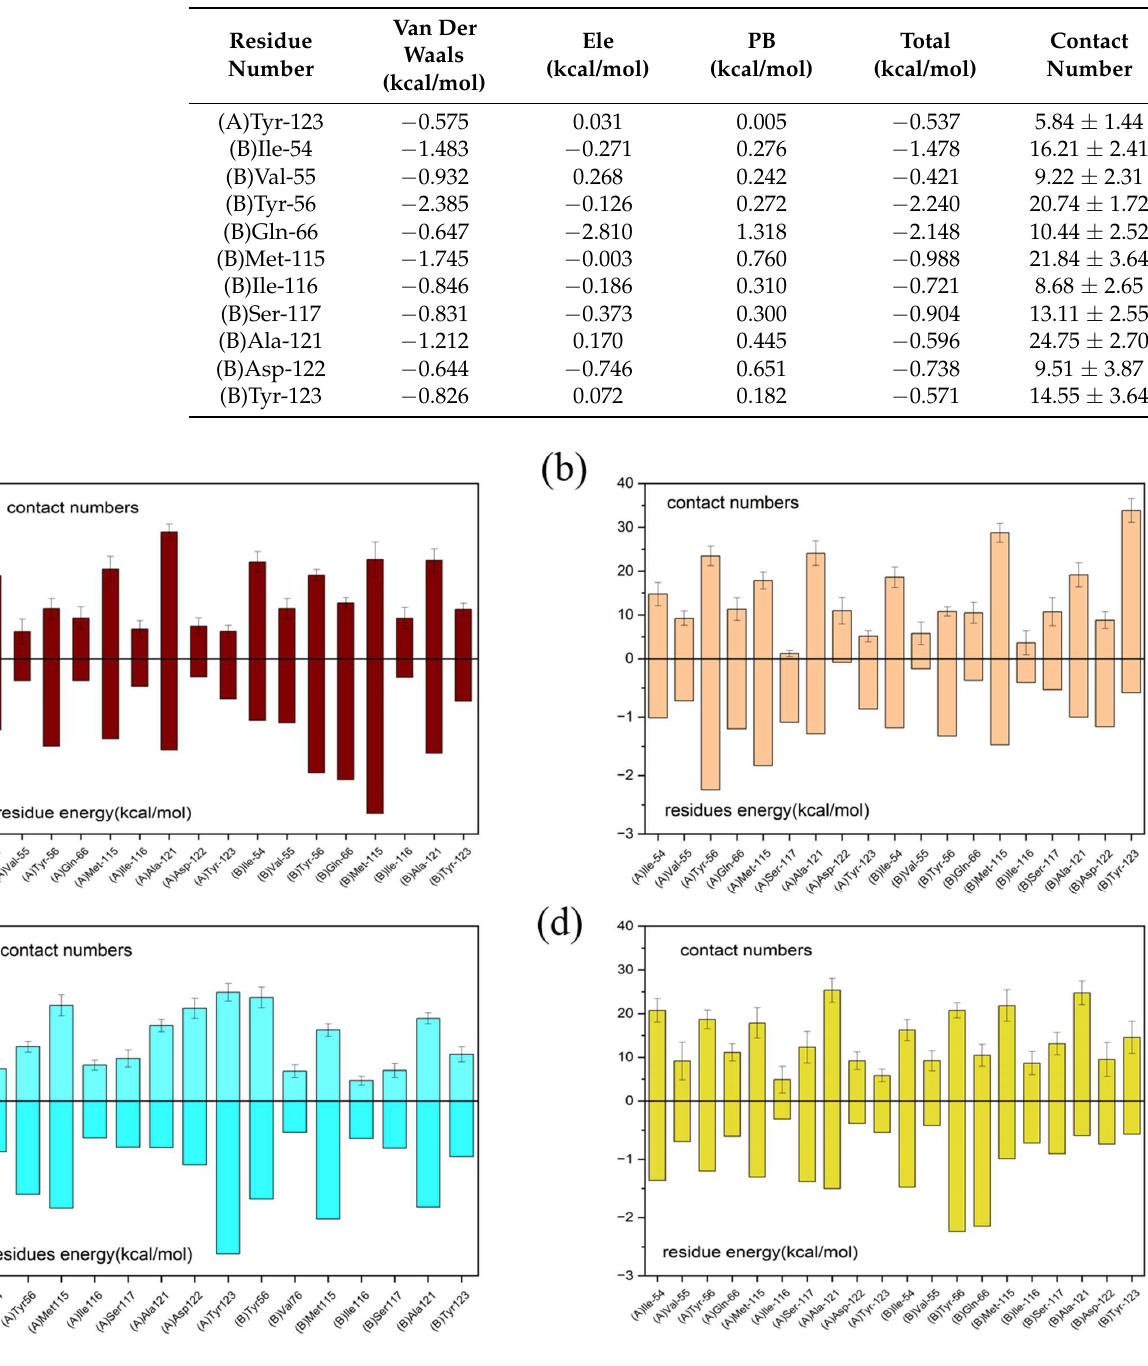
Figure 5. Residue energy decomposition of key residues and contact numbers between the small molecules and the PD-L1 dimer belonging to ( a ) capsaicin, ( b ) zucapsaicin, ( c ) curcumin and ( d ) 6-gingerol systems (kcal/mol).